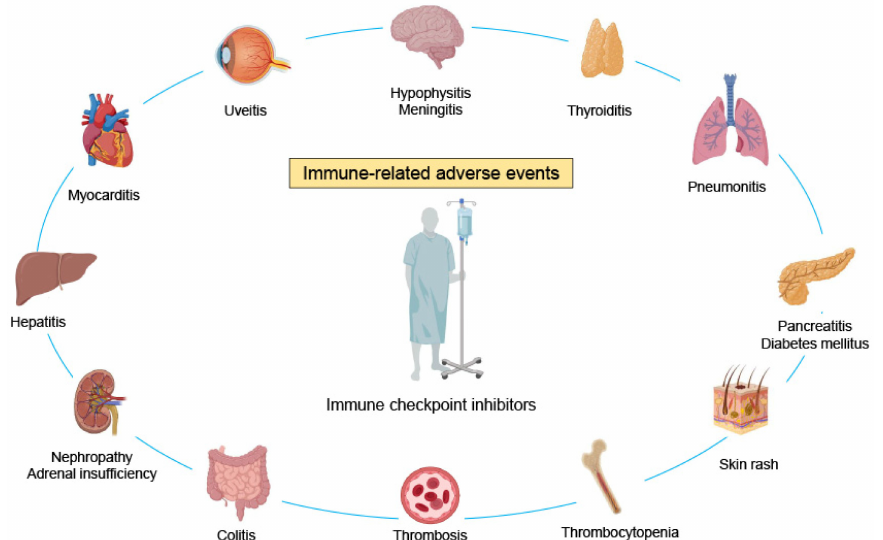
Figure 1. Immune-related adverse events affect multiple organs. Immune checkpoint inhibitors can cause side effects called immune-related adverse events (irAEs), which involve hypophysitis, meningitis, thyroiditis, uveitis, pneumonitis, myocarditis, pancreatitis (diabetes mellites), hepatitis, erythema, nephropathy, adrenal insufficiency, thrombocytopenia, colitis, thrombosis, and other manifestations. Colitis, hypophysitis, and skin rash occur more frequently with anti-cytotoxic T-lymphocyte-associated protein 4 (CTLA-4) antibodies, whereas pneumonitis, hypothyroidism, and vitiligo are more common with anti-programmed cell death protein-1 (PD-1) and anti-programmed cell death ligand-1 (PD-L1)